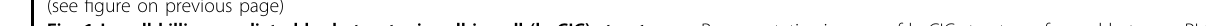
Fig. 1 In-cell killing mediated by heterotypic cell-in-cell (heCIC) structure. a Representative images of heCIC structures formed between PLC/ PRF/5 cell (phalloidin-red) and CCRF-CEM cells (EGFP-green). Scale bar, 20 µm. b The frequencies of heCIC formation in a panel of liver tumor cell lines co-cultured with CCRF-CEM cells for 8 h. n > 800 cells for each cell line. Data are means ± SD of quintuple experiments. c Correlation between heCIC frequency and immune killing ef fi ciency in a panel of liver tumor cell lines. Data are means ± SD of triplicate experiments. d , e Fate analysis of NK92MI cells internalized into PLC/PRF/5 cells stained with lysotracker-red by time-lapse imaging of 24 h. Scale bar, 10 µm. n = 125. f , g Fate analysis of PLC/ PRF/5 cells that were in contact with NK92MI cells from outside (kiss), or internalized NK92MI cells (CIC), by time-lapse imaging of 24 h. Scale bar, 10 µm. n = 80 for kiss-killing, 117 for CIC, respectively. Data are means ± SD of triplicate experiments. h Transmission electron microscope image for a heCIC structure with an NK92MI cell inside a dying PLC/PRF/5 cell. The zoomed images showed the broken cellular membrane (red arrows) of the dying host PLC/PRF/5 cells. Scale bars: 5 µm, 5 µm, 1 µm, and 1 µm, respectively. i Representative images for a heCIC structure with an NK92MI cell (red arrow) internalized by a PLC/PRF/5 cell, stained with anti-granzyme B antibody (red), phalloidin (green), and DAPI (blue). White arrows indicate blebs on PLC/PRF/5 cell. Scale bar, 10 µm. j The formation of heCIC structures between PLC/PRF/5 and NK92MI cells for 6 h (E: T = 4: 1), treated with DMSO, Y27632 (10 µM), and Z-AAD-CMK (50 µM), respectively, as quanti fi ed on cytospin images. Data are means ± SD of quintuple experiments. *** P < 0.001. k The percentage of PLC/PRF/5 cells that survived 24 h co-culture with NK92MI cells in the presence of Y27632 (10 µM), Z-AAD-CMK (50 µM), and Y27632 plus Z-AAD-CMK, respectively, quanti fi ed by way of CCK8 incorporation. Data are means ± SD of triplicate experiments. ** P < 0.01; *** P <